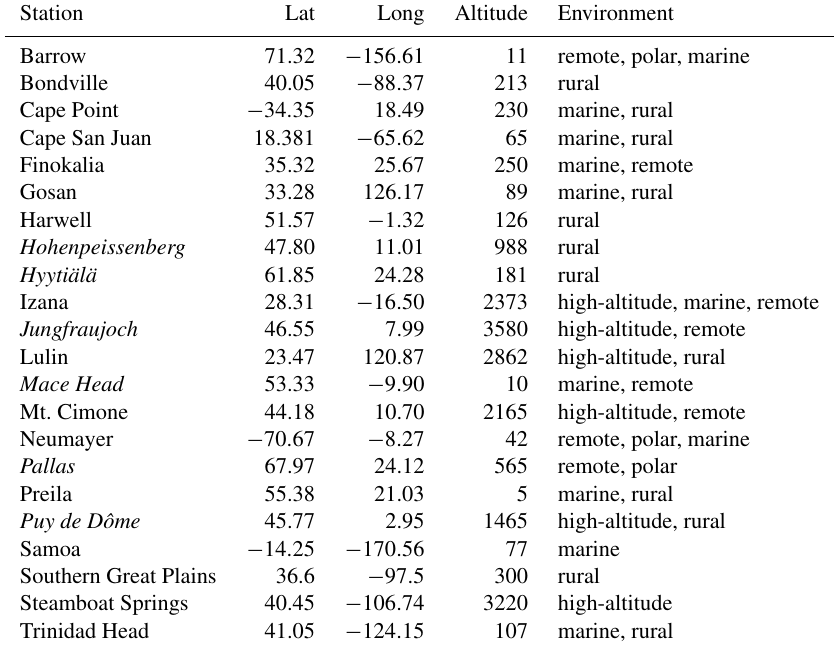
Table 2. Measurement stations used in the comparison with atmospheric particle concentrations in Figs. 7 and 8. Station coordinates are taken from the EBAS data files. “Altitude” is given in metres. Station names in italic indicate locations with ion measurements. Station Lat Long